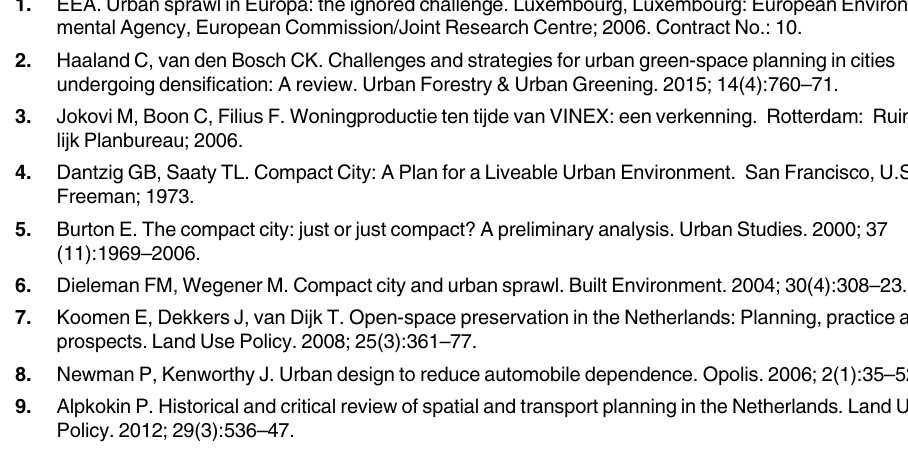
S2 Table. Actual development values per period for the three main development